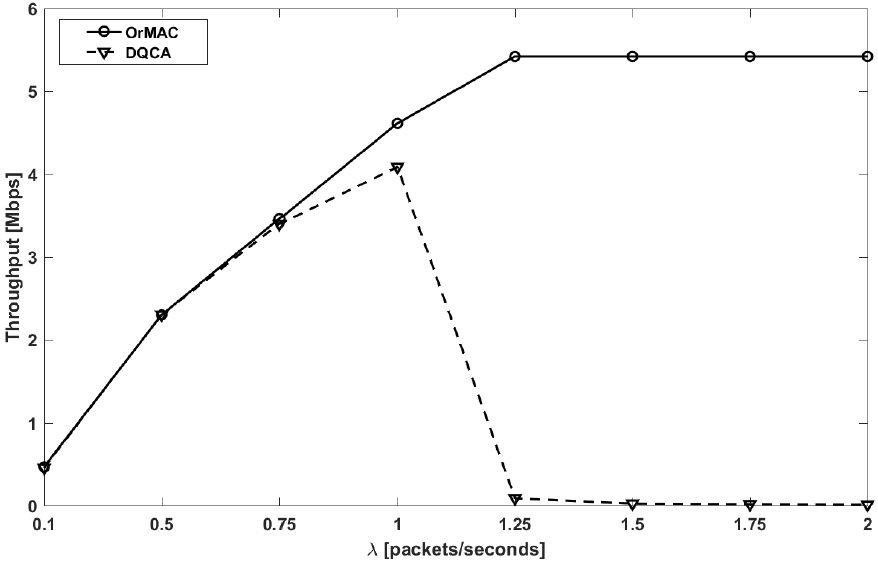
Figure 7. Throughput versus offered traffic load.